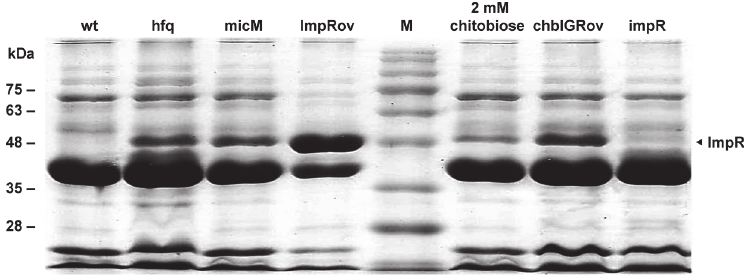
Fig 1. The SDS-PAGE profile of OMPs from overnight cultures of wild-type, its derivatives and wild- type treated with chitobiose. The representative result from three independent experiments is shown. The arrow indicates the band of ImpR. M, marker; wt, wild-type; hfq, hfq mutant; micM, micM mutant; ImpRov, ImpR-overexpressing strain; chbIGRov, chbBC -IGR-overexpressing strain; impR, impR mutant.